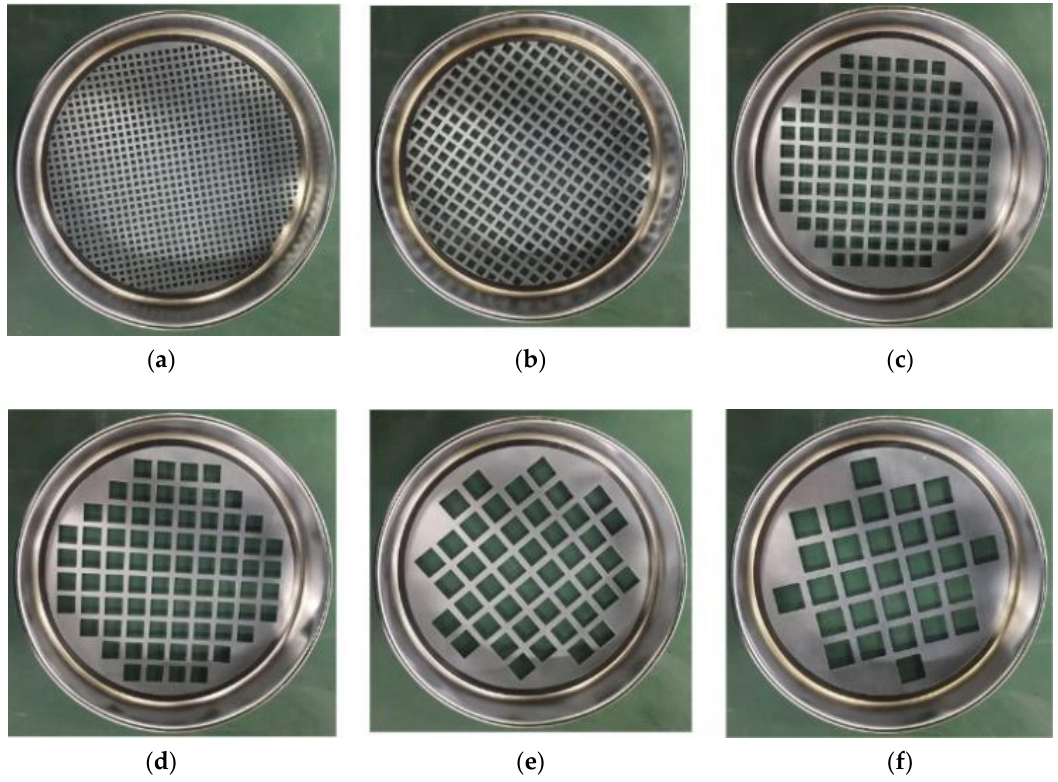
Figure 1. Square aperture sieves. ( a ) 5 mm. ( b ) 10 mm. ( c ) 15 mm. ( d ) 20 mm. ( e ) 25 mm. ( f ) 30 mm.